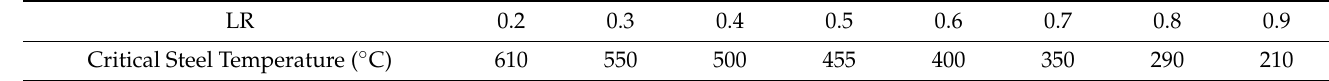
Table 1. Critical average temperatures for structural fire failure of channel section joists at different LRs.